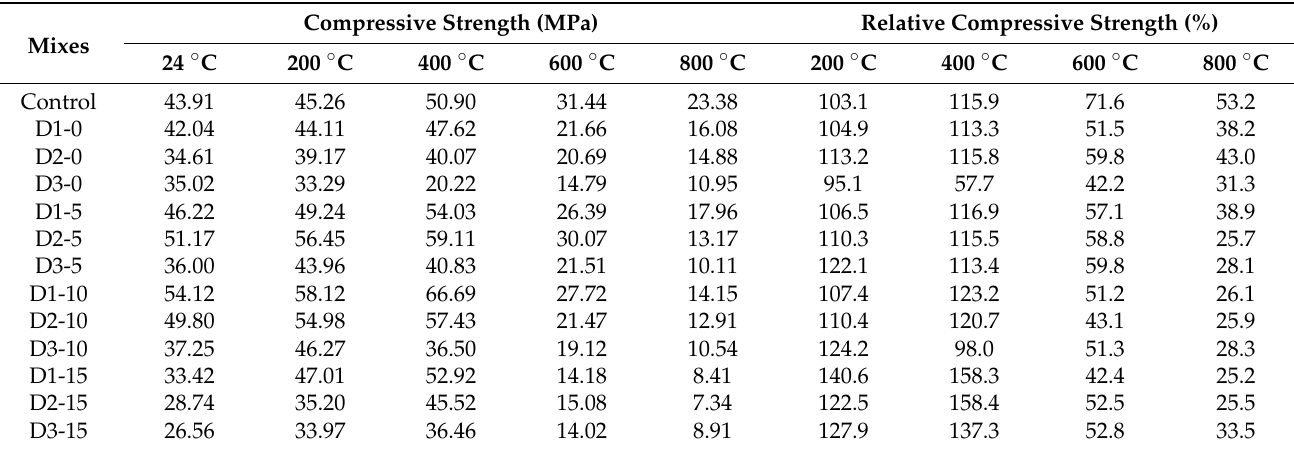
Table 4. Compressive strength results after subjection to elevated